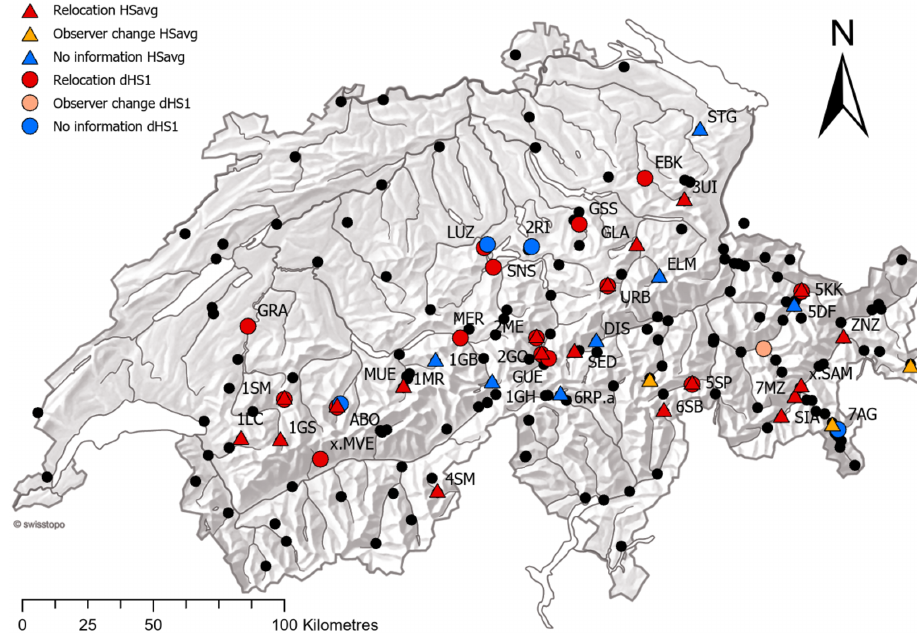
Figure 7. Map highlighting the location of series with identified valid break points and information from metadata where applicable. Series where no break points are detected are marked with black circles.